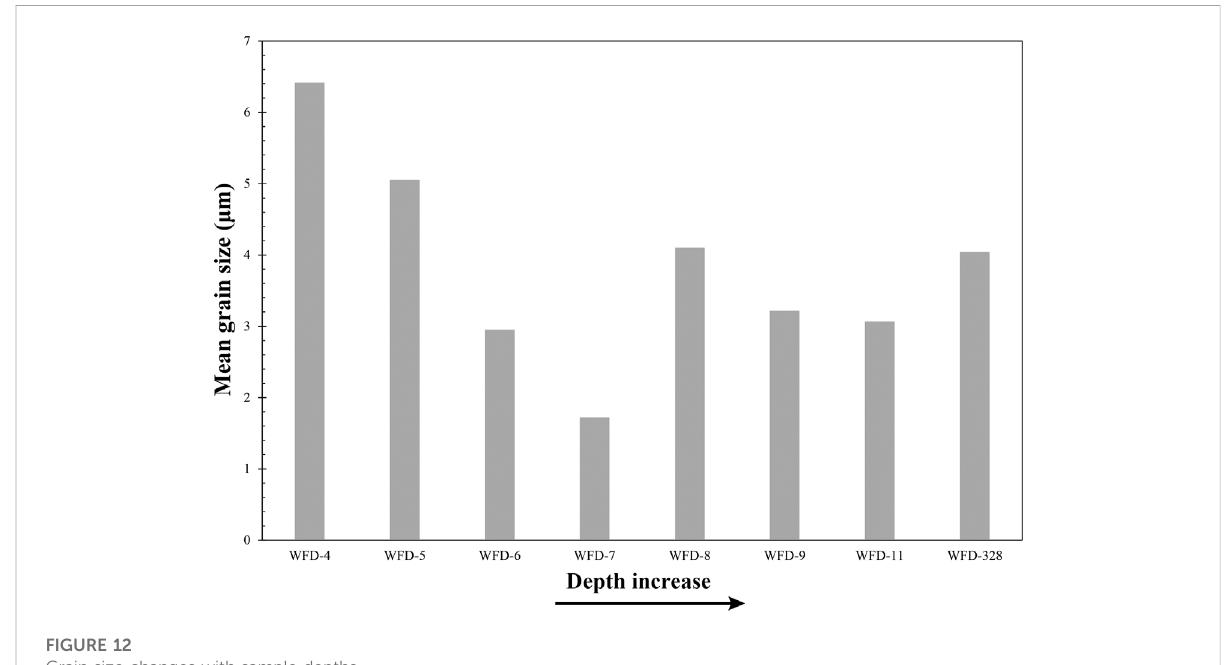
FIGURE 12 Grain size changes with sample